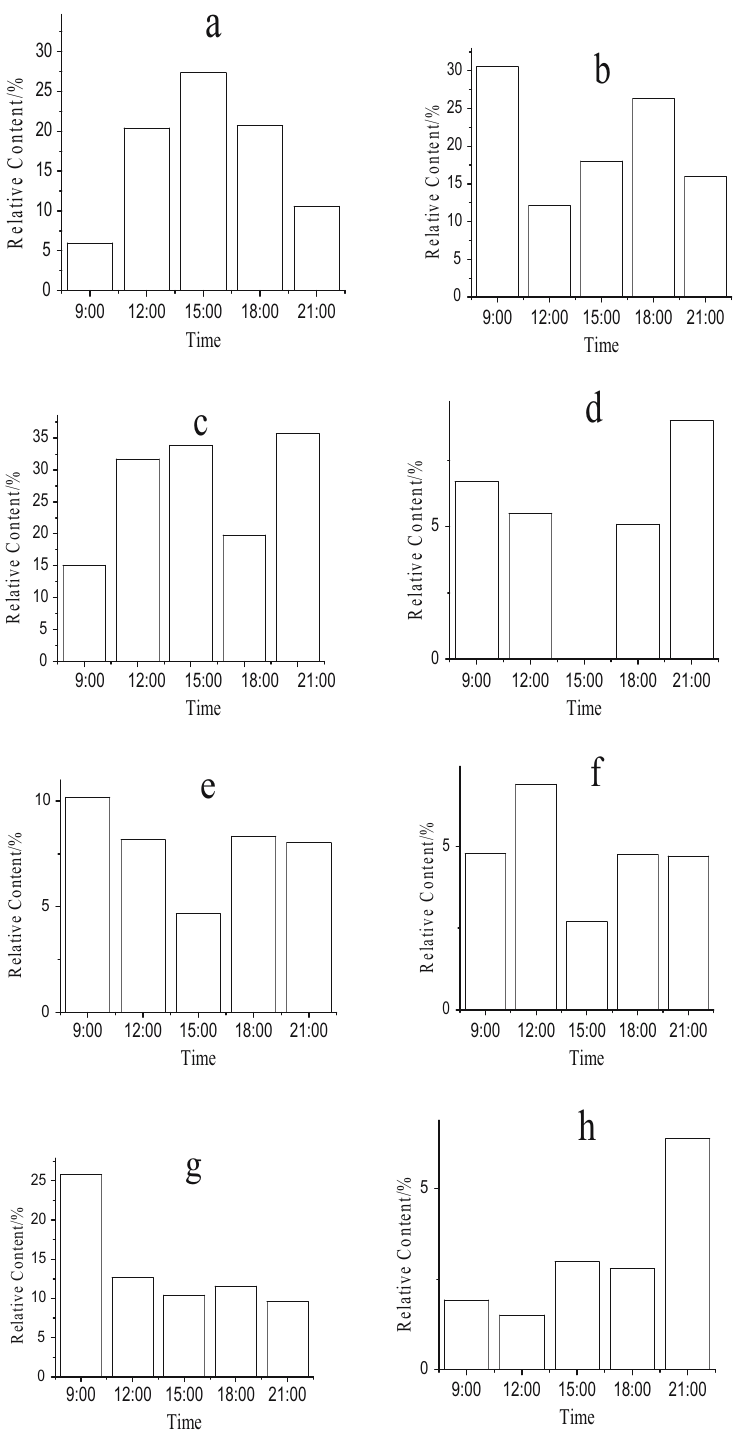
Figure 3: The diurnal variation of total release amount of fl oral scent from tulip (( a ) alcohol, ( b ) fattyhydrocarbon, ( c ) terpenes, ( d ) aldehydes, ( e ) ketones, ( f ) esters, ( g ) arenes, ( h ) others )